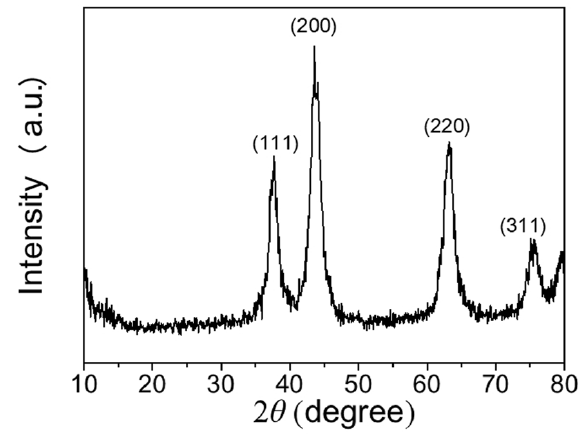
Figure 2. XRD pattern of NiO x NPs fabricated by chemical precipitation method.